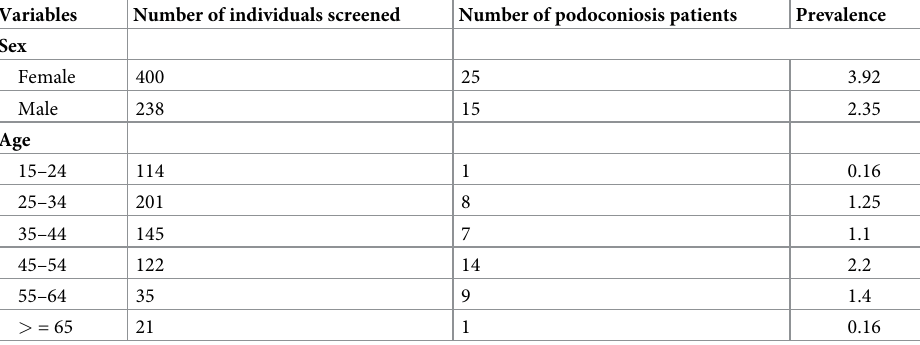
Table 2. Age and sex distribution of respondents who had podoconioisis in Dano district, 2018.